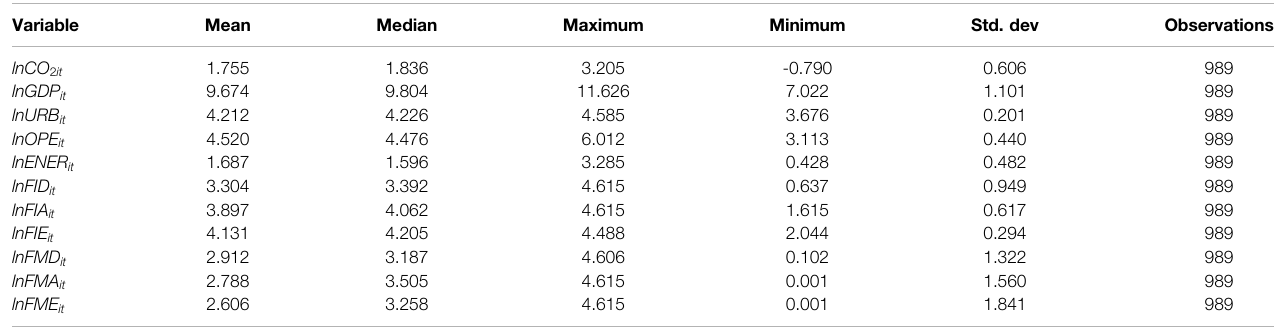
TABLE 2 | Summary statistics over the years 1990 – 2020.